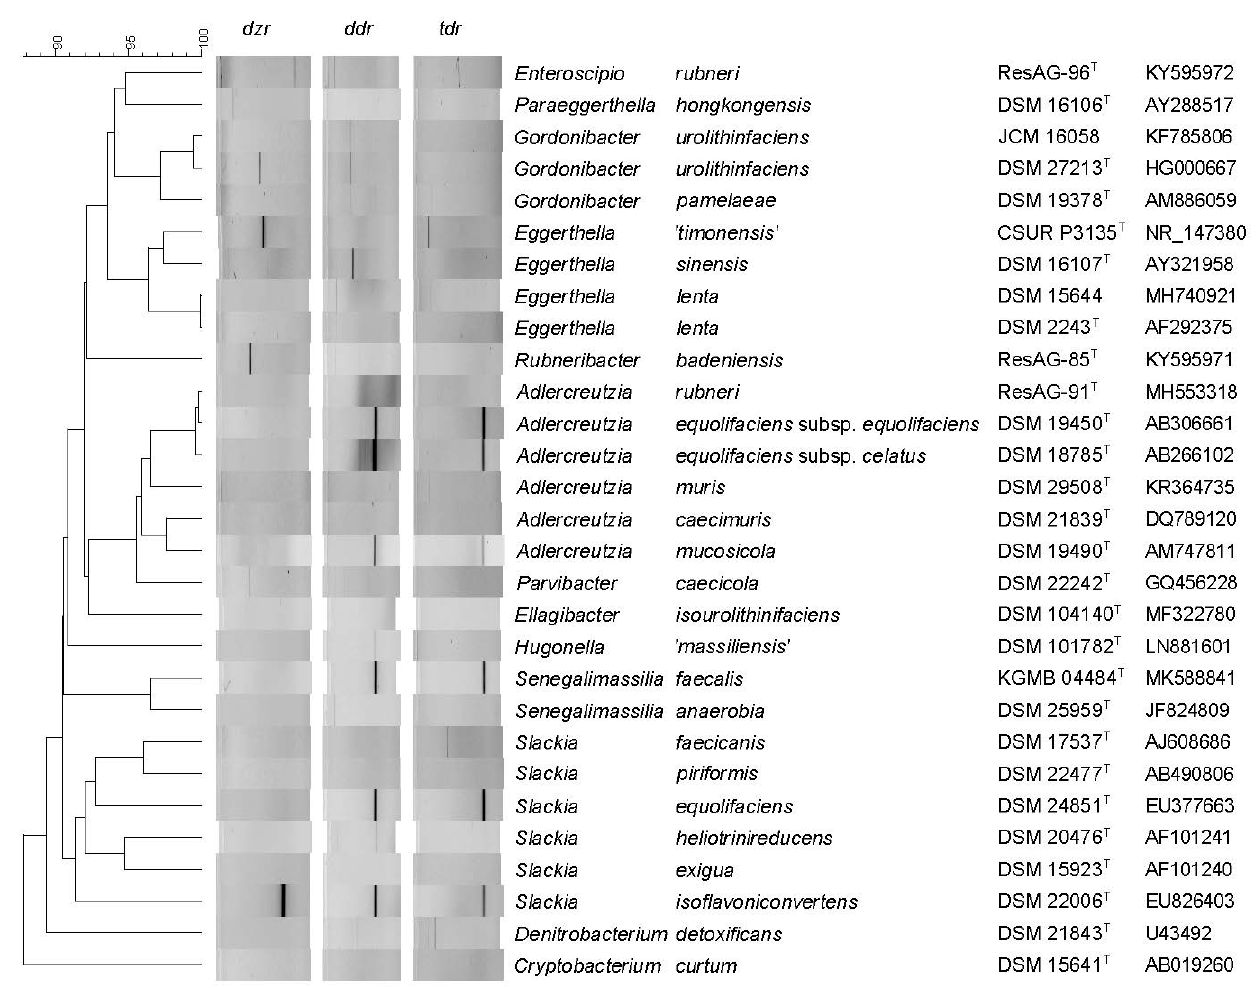
Figure 4. Phylogenetic tree based on 16S rRNA gene sequences of a total of 29 strains belonging to the Eggerthellaceae and Coriobacteriaceae . Clustering was performed based on multiple alignment and unweighted pair group method with arithmetic mean (UPGMA). Results of a PCR with primers amplifying for dzr , ddr and tdr [29] are shown next to the cluster.